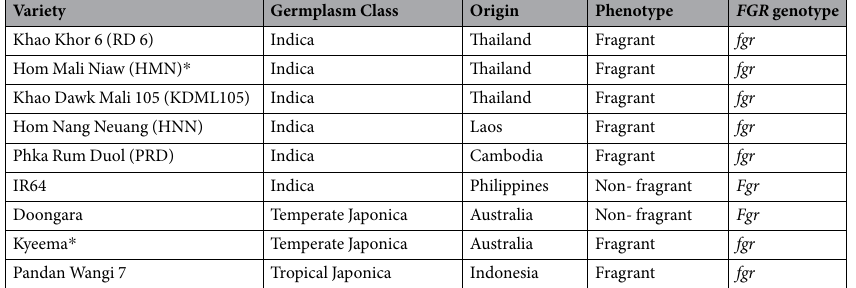
Table 2. Elite rice varieties from Southeast Asia and Australia used in this study (Set 1). * Two samples from different plots have been used in Set